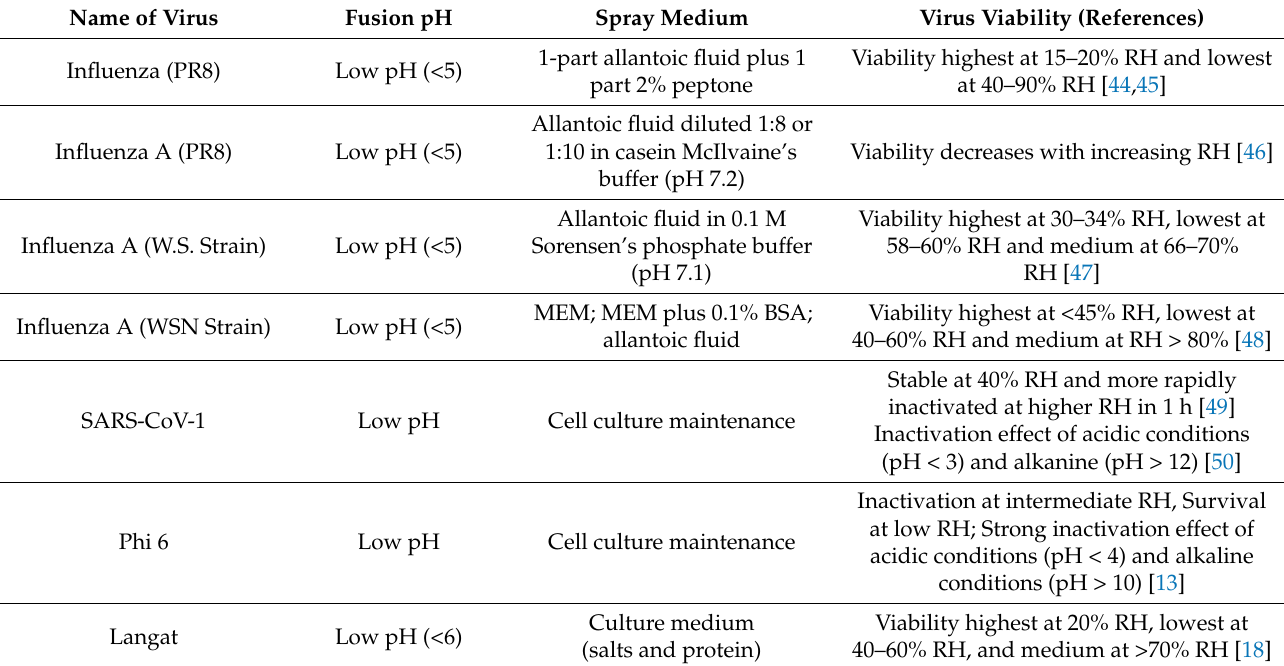
Table 1. Information of fusion process for various enveloped viruses, modified version